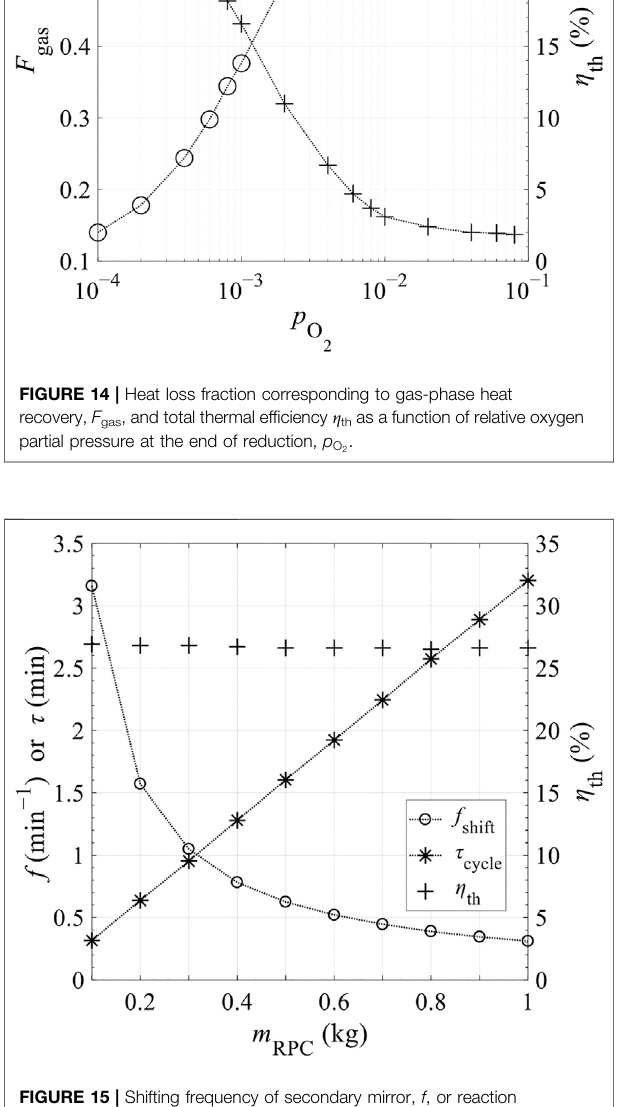
FIGURE 17 | Effect of number of CRRs in the pre-cooling and pre- heating zones, N , on total solar-to-fuel ef fi ciency η th in different levels of reductiontemperature, T red ,withperfectgas-phaseheatrecoveryandrelative oxygen partial pressure p O of 5 × 10 – 5 2